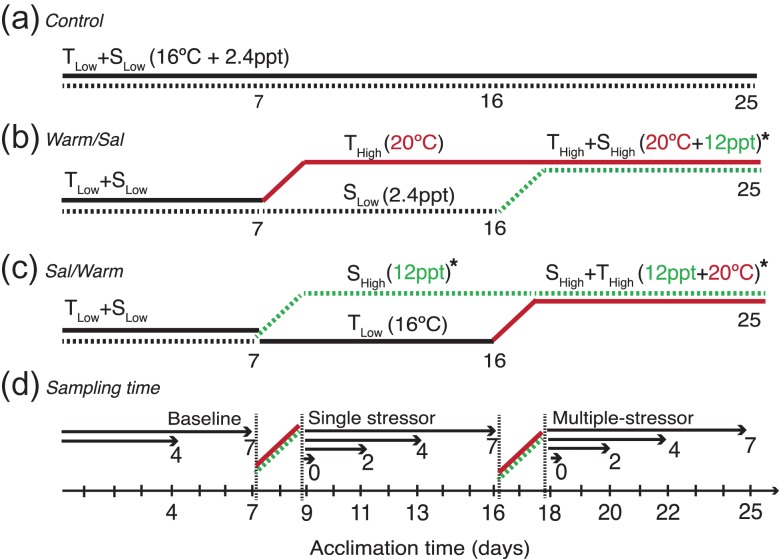
Experimental design, on a scale of days, for initial and subsequent exposures to multiple stressors. Each timeline represents experimental stressor regimes including (a) Control conditions, (b) Warm/Sal, an initial thermal stressor (THigh) followed by a subsequent salinity increase (THigh:SHigh), and (c) Sal/Warm, an initial salinity exposure (SHigh) followed by a subsequent temperature increased (SHigh:THigh). Physiological assessments were made across time (d) after each change in exposures to assess responses over time. *Largemouth Bass high salinity exposure was 8 ppt, whereas Delta Smelt and Silversides exposure were 12 ppt.